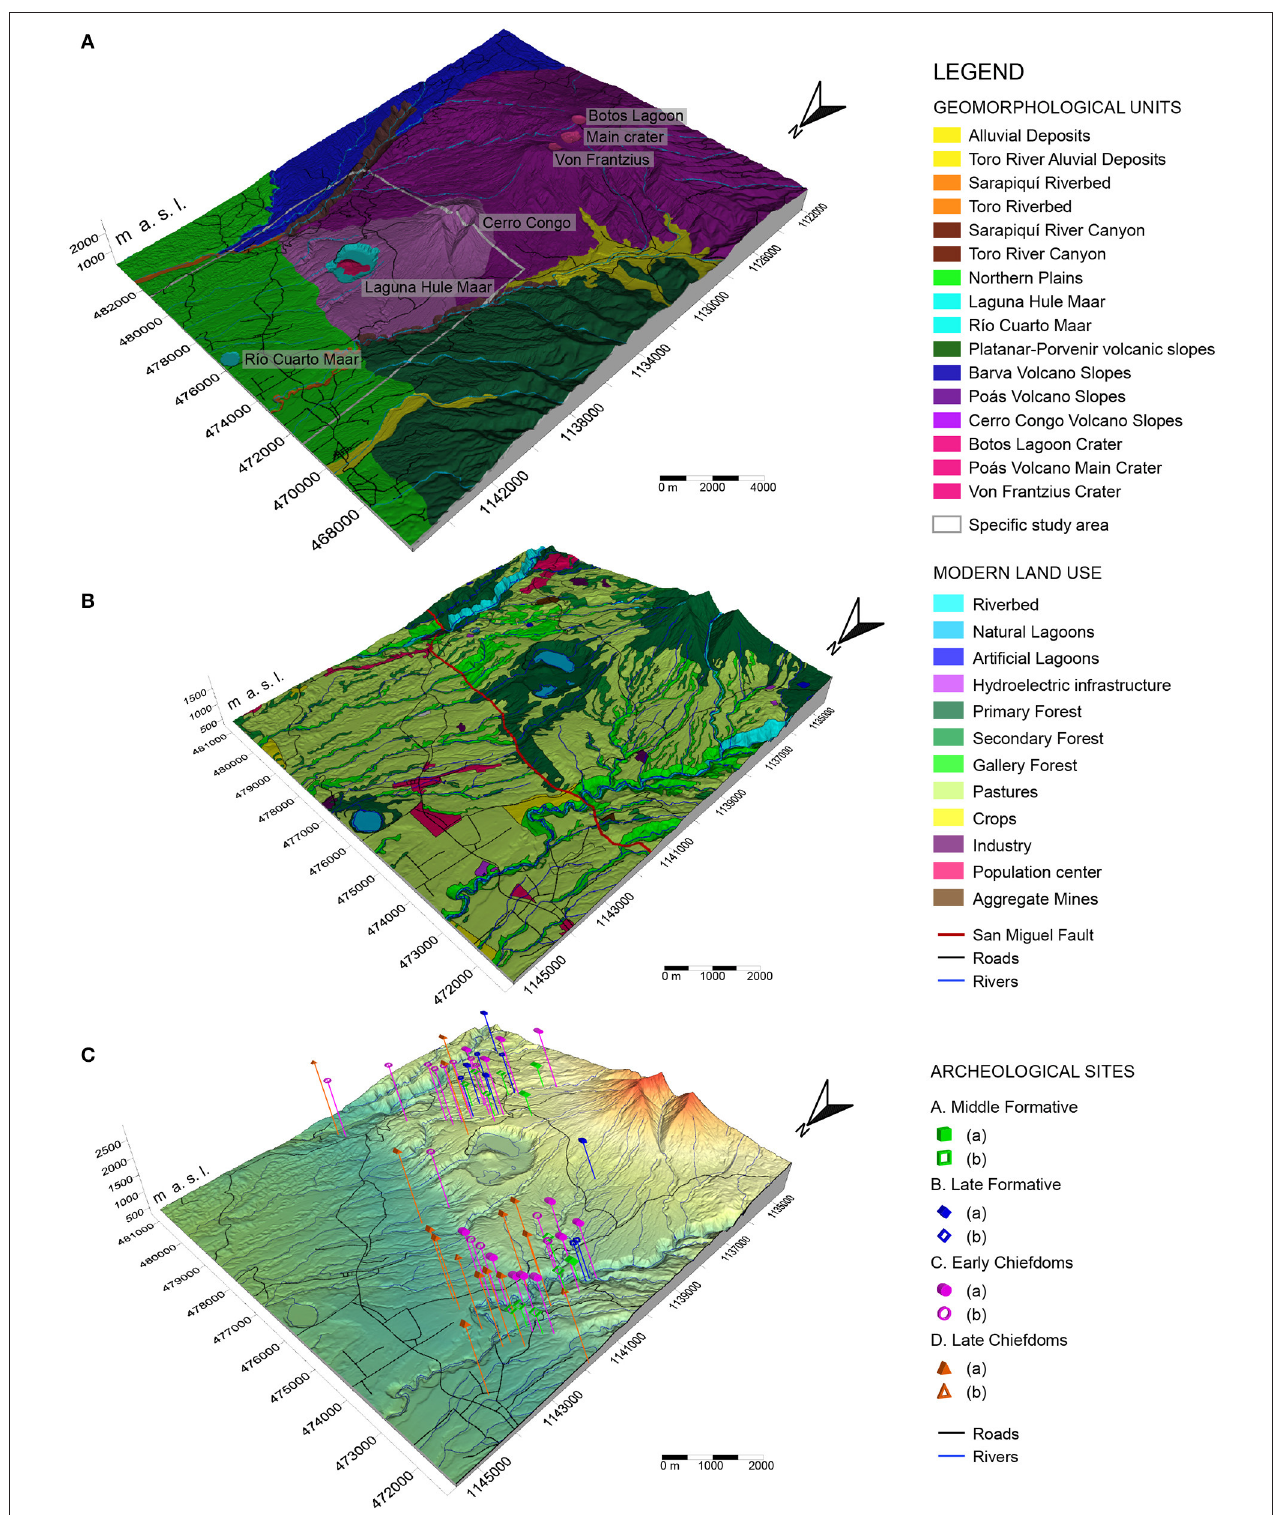
FIGURE 3 | (A) Geomorphological map of the study area north of the Poás Volcano main crater. These block diagrams were created based on a DEM model of the area from the available aerial LiDAR data; (B) Modern land use distribution of the focus area (highlighted in white in A ). Note how the San Miguel Fault escarpment (SMFE) physically subdivides the area in two parts (north and south); (C) Location of archeological sites where artifacts have been recovered. Sites are divided into Middle Formative (4,500–3,000 BCE), Late Formative (3,000–2,200 BCE), Early Chiefdoms (2,200–1,200 BCE) and Late Chiefdoms (1,200–500 BCE); and ranked based on the quality of the archeological remains recovered: (a) higher, (b) lower (modified from Alvarado et al., 2011).